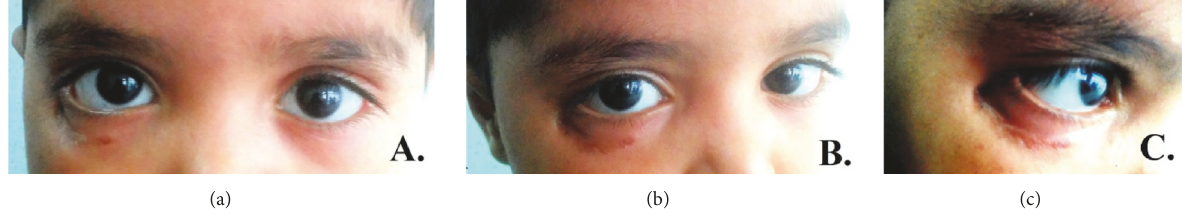
Figure 4: Postchemotherapy clinical photograph of the patient localizing the resolution of the site at inferolateral right